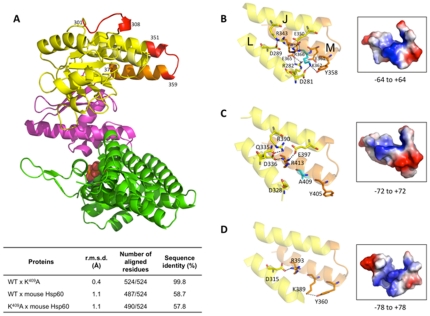
Structural modeling of M. leprae WT and K409A Hsp65 and mouse Hsp60.A) Superposition of the WT and K409A M. leprae Hsp65 overall structures showing the three characteristic domains: apical [yellow], intermediate [red], and equatorial [green], with the ADP evidenced in spheres. The peptide region [352 to 371 residues in WT Hsp65] is evidenced in orange and regions with high B-factor described by [21] are shown in red. The inset table shows the results of the structural alignment of the proteins. B, C, and D) Main differences in the polar contacts performed by the peptide region and that affect the electrostatic potential in the WT Hsp65, Hsp65 K409A, and mouse Hsp60 proteins, respectively. Red color shows negative and blue positive charges.